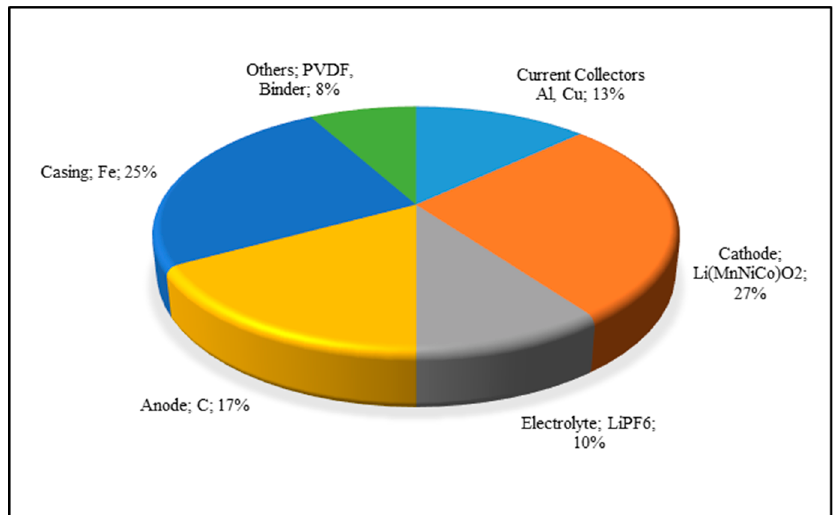
Figure 1. Components of a common Lithium-ion battery (LIB). PVDF stands for Polyvinylidene Fluoride [3–7].